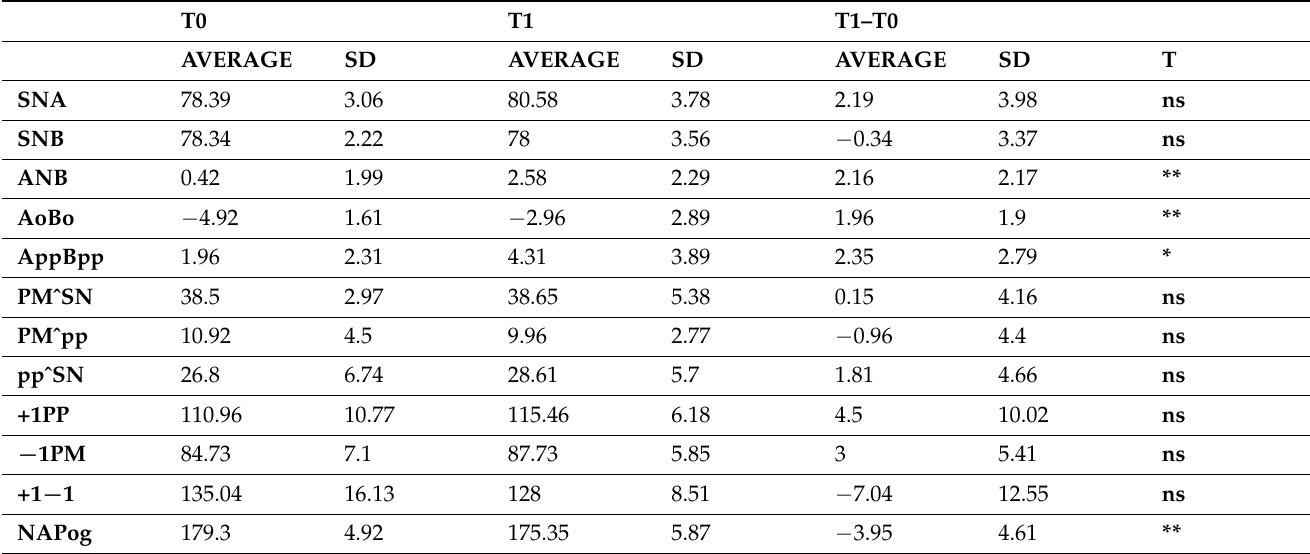
Table 5. Study results for the rapid palatal expander + Delaire sequence.